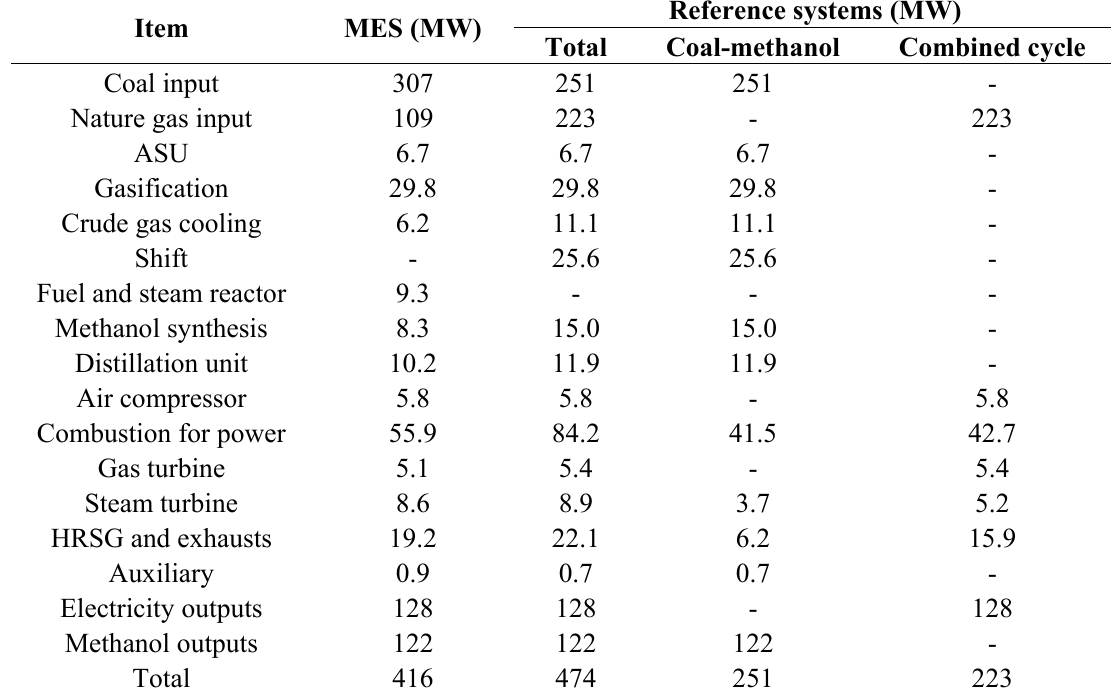
Table 3. Exergy analyses of the MES and reference